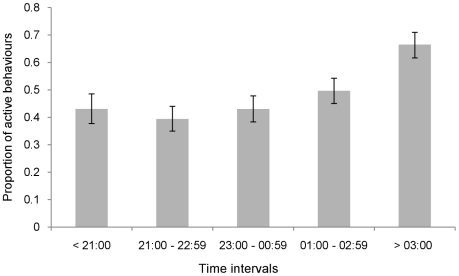
Proportion of active behaviours across the night excluding periods of astronomical twilight.The standard error of the logit values were used to construct 95% confidence intervals indicated by the error bar. Means are adjusted for other fixed effects.